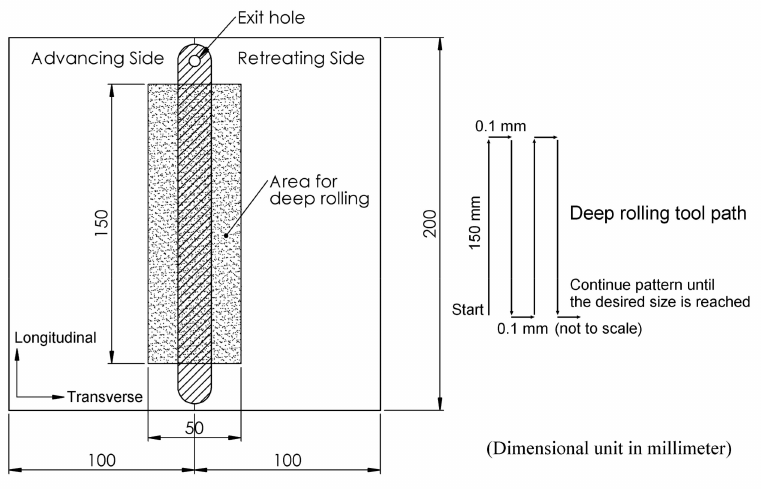
Figure 5. Designed area and tool path for the deep-rolling